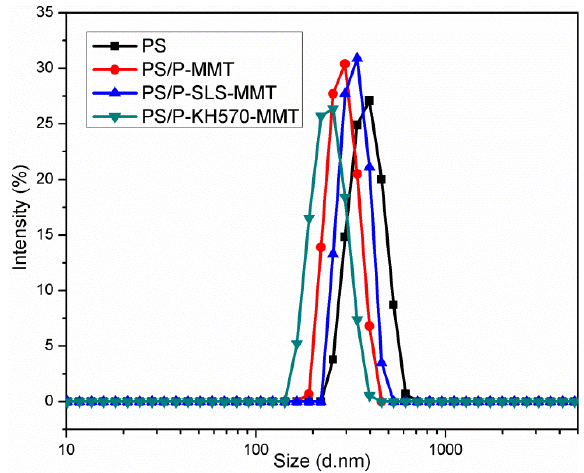
Figure 8. Size distribution curves of PS, PS / P-MMT, PS / P-SLS-MMT, and PS / P-KH570-MMT. Table 2. Particle size distribution of PS, PS / P-MMT, PS / P-SLS-MMT, and PS / P-KH570-MMT samples.